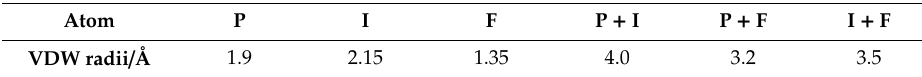
Table 2. Van der Waals radii of P, I and F atoms (Pauling, Ref.